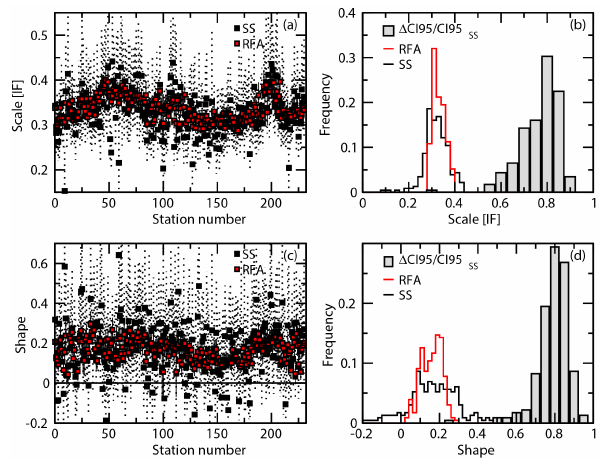
Figure 7. (a, c) Station-by-station GEV scale (IF units) and shape parameters, respectively, with 95% confidence intervals from fits to single-station (SS) and pooled-station (RFA) data. Dotted bars denote SS errors and solid bars RFA errors. (b, d) Frequency his- tograms of the SS and RFA estimates of the scale and shape param- eters, respectively, across the region, and the fractional reductions of CI95 by RFA (grey-filled bars) for both parameters.